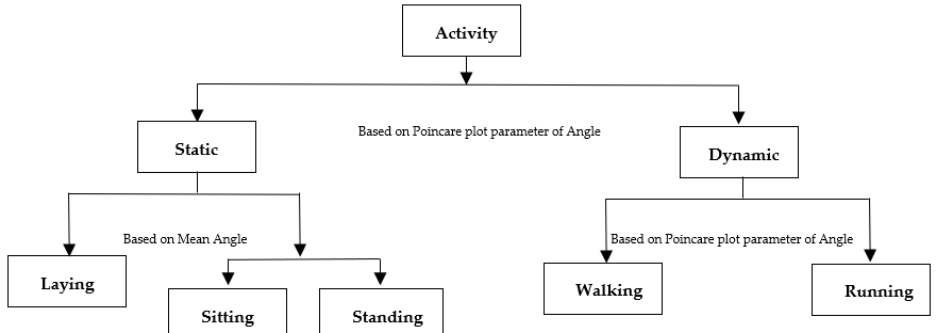
Figure 1. Step by step activity classification process.